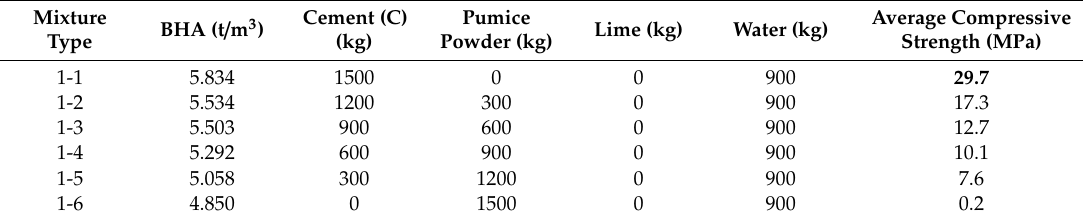
Table 22. Type-1 mixture quantity, unit volume weight and compressive strength test results.